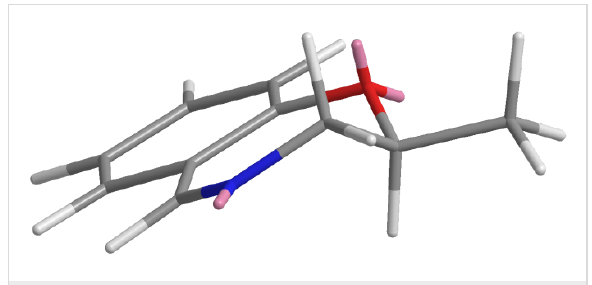
Figure 1: Model of the expected preferred conformation of imine 5a , as minimized using CSC Chem3D